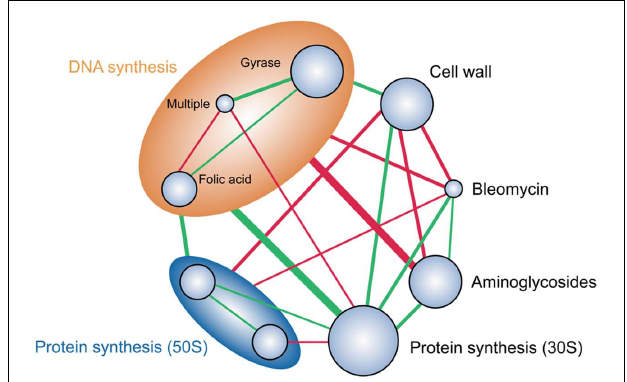
FIGURE 5 | Functional classification of antimicrobial drugs by their pairwise interactions. Adapted form (Yeh et al., 2006). Synergistic (red) and antagonistic (green) interactions are highlighted. Circle size of the drug classes represents the number of compounds examined and the line thickness the number of interactions.The larger ellipses show higher-level functional classification of DNA synthesis inhibitors (orange) and protein synthesis inhibitors of the 50S ribosome subunit. Selection of gene targets from classes known to have synergistic inhibition properties could aid in the selection of genes for the design of antisense-based screens for polypharmacological targets and